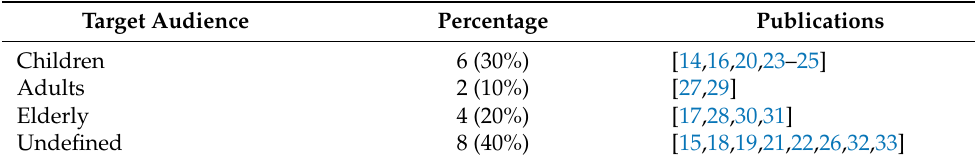
Table 4. Distribution of papers based on gamification target audience.